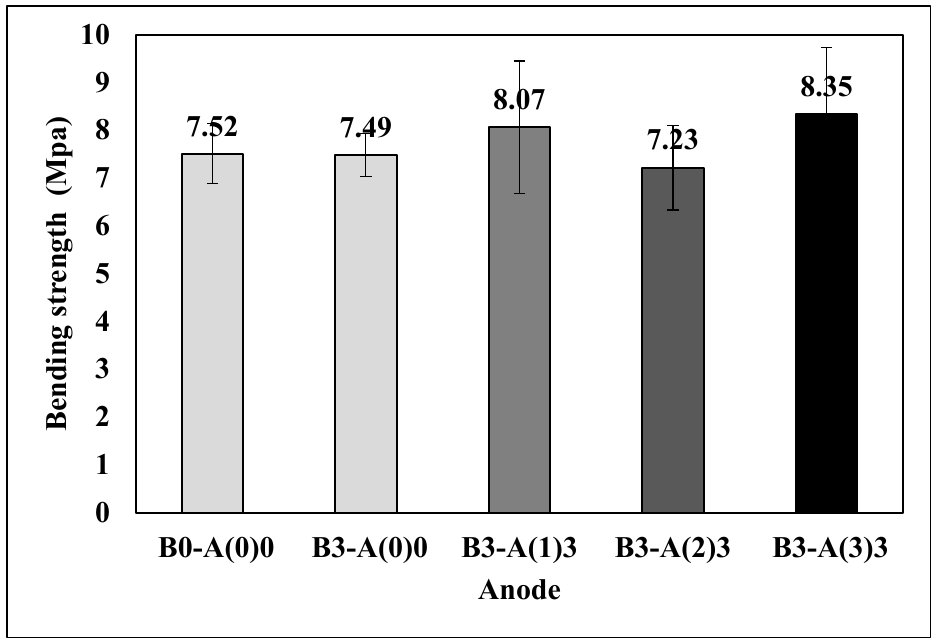
Figure 6. Bending strength of the anodes.